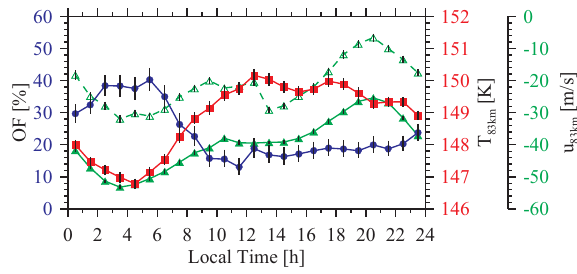
Fig. 8. Diurnal variation of NLC occurrence determined from ALOMAR RMR-lidar ( β max > 4, blue circles) and atmospheric pa- rameters at 83km altitude during times of lidar measurements: tem- perature (red squares) and zonal wind (green filled triangles) as cal- culated by LIMA, zonal wind measured by the MF-radar (green open triangles, dashed line). RMR and LIMA data are integrated from 1997 to 2010, MF data from 1999 to 2010. Vertical bars indi- cate confidence limits for the occurrence at 95%-level and errors of the means for temperature and